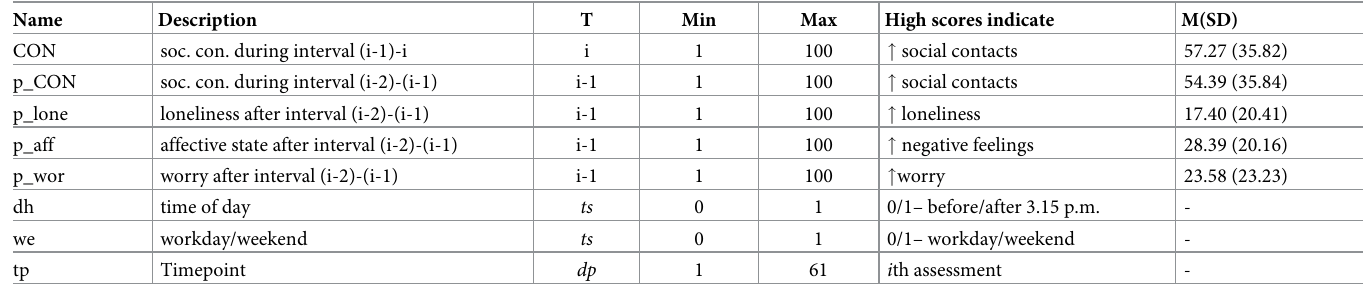
Table 3. Overview and descriptive statistics of variables derived from the ESM study and interpretational aids.